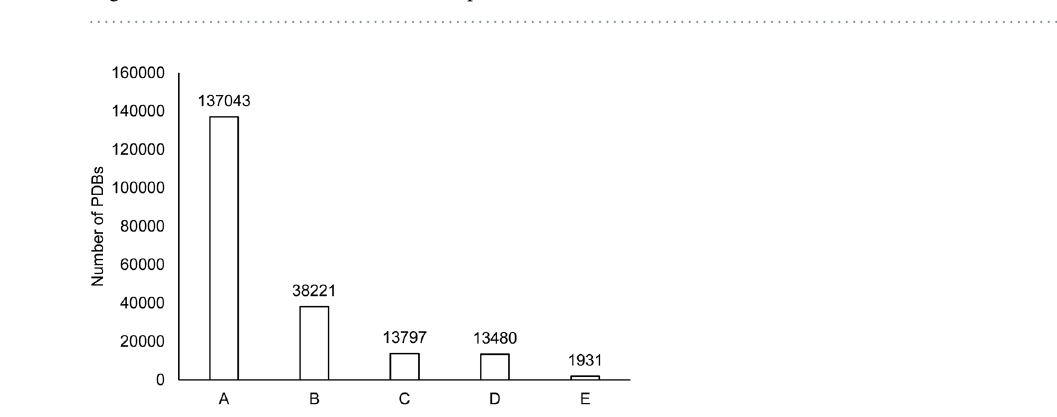
Figure 2. Definition of an atomic contact pair (ACP).